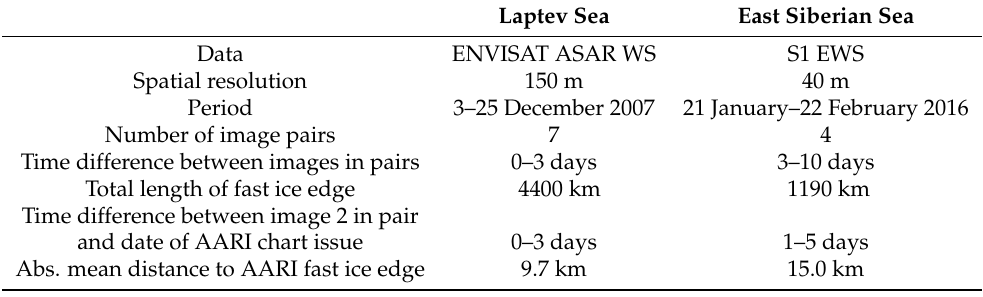
Table 1. Cross-comparison data and results.